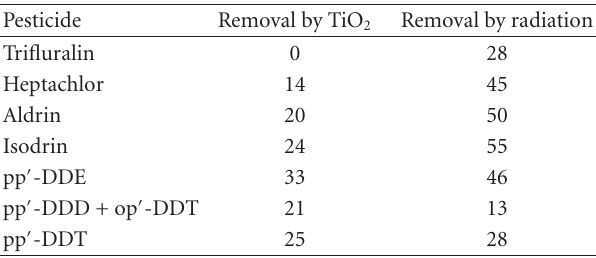
Table 6: Degradation of pesticides in blank